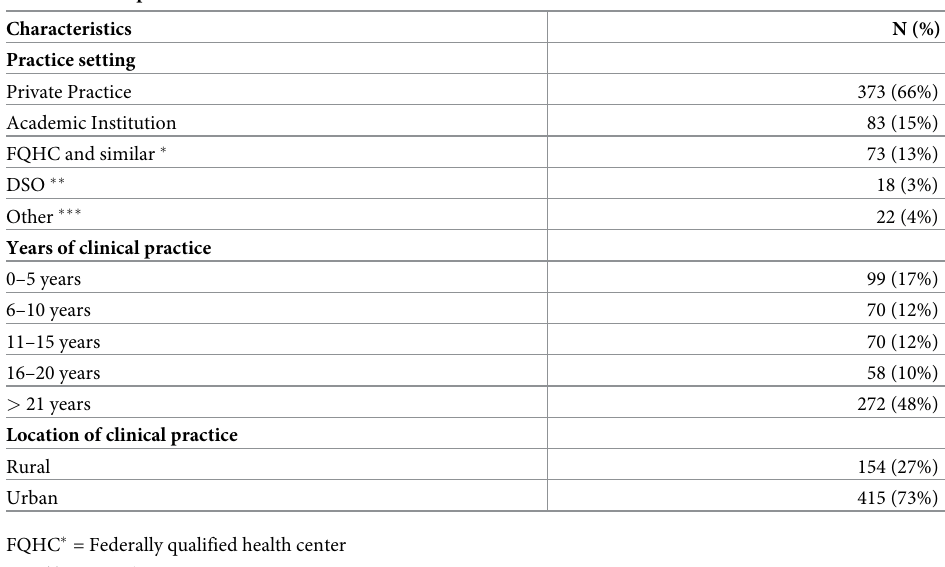
Table 1. Participant